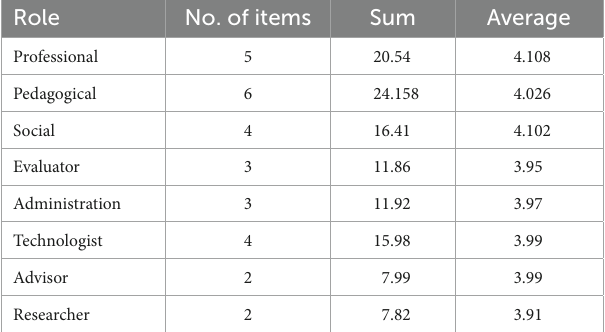
TABLE 5 Data analysis of categories and roles.